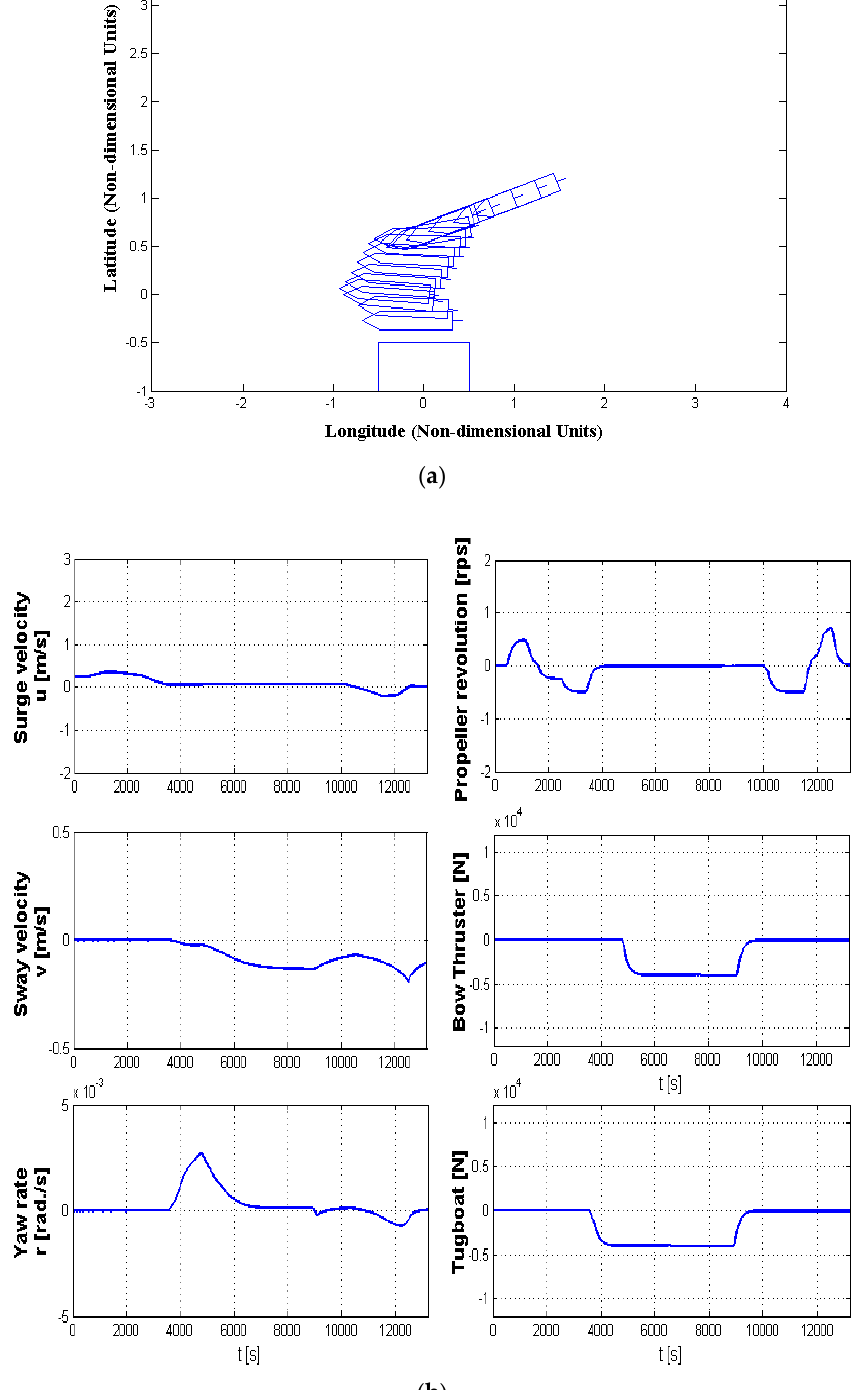
Figure 10. Simulation result for the first case: ( a ) The ship’s track in berthing control process; ( b ) The time history of ship berthing process.